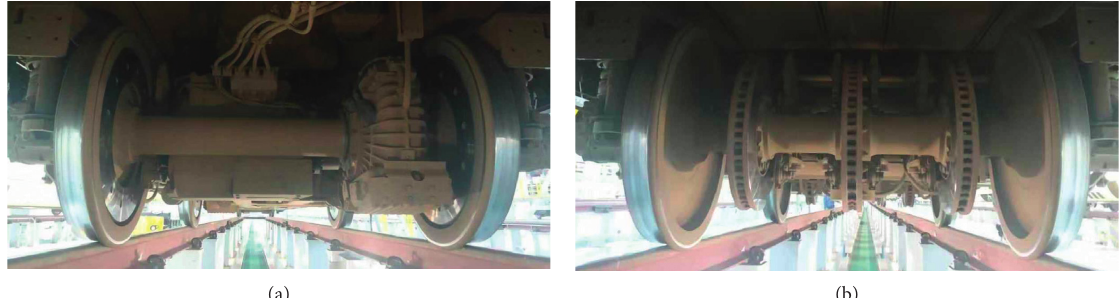
Figure 1: Two wheelset forms: (a) the power wheelset, (b) the trailer wheelset.